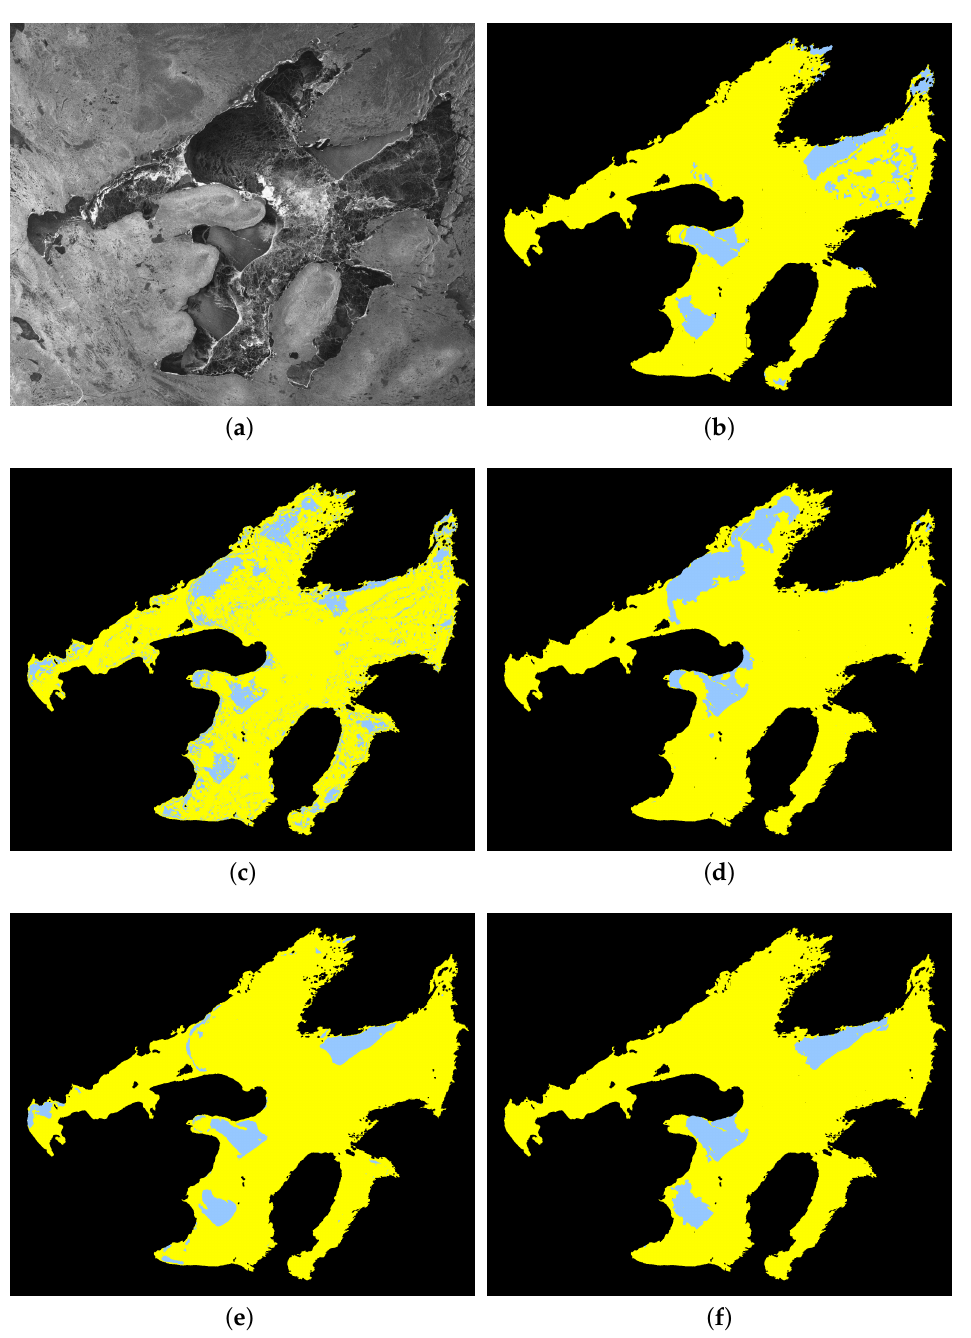
Figure 5. Ice-water classification of 27 November 2014 scene (scene ID: 20141127_143745). Ice is shown in yellow and water in blue. ( a ) HH image. ( b ) IRGS-Manual with accuracy of 86.0%. ( c ) SVM pixel-wise classification with accuracy of 81.0%. ( d ) IRGS-SVM; IRGS segmentation labeled by SVM with accuracy of 84.8%. ( e ) RF pixel-wise classification with accuracy of 94.3%. ( f ) IRGS-RF; IRGS segmentation labeled by RF with accuracy of